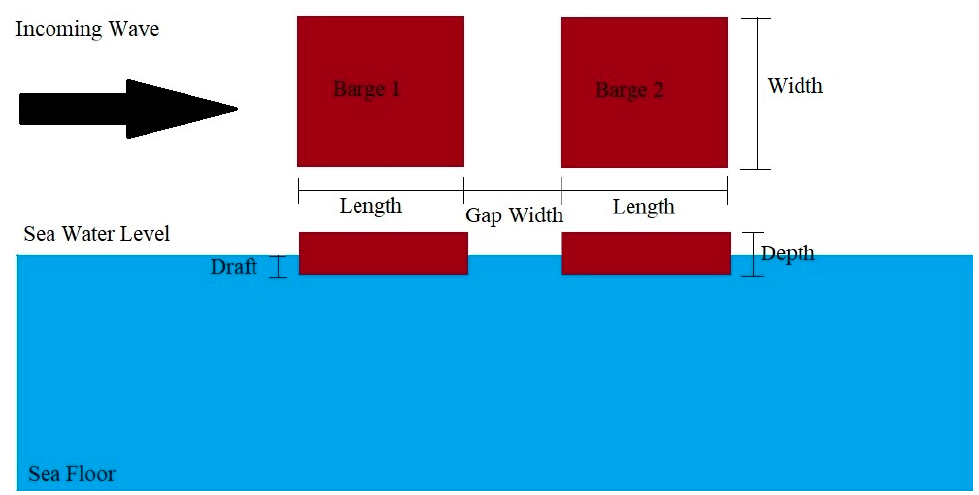
Figure 12. Preliminary design of barges. Table 1. Effect of gap width between the barges on resonant